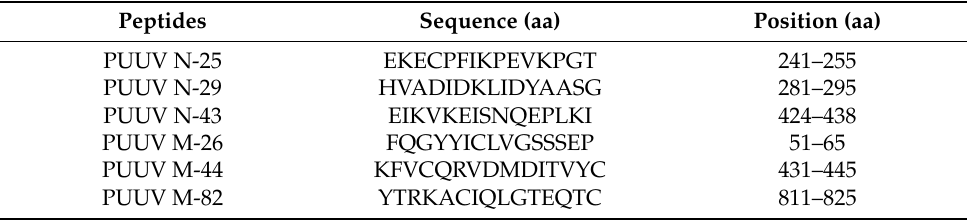
Table 1. Peptides used in this